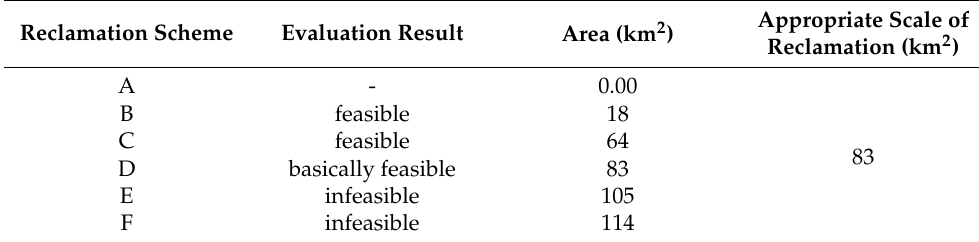
Table 24. The maximum allowable area for CR in Haizhou Bay (scenario